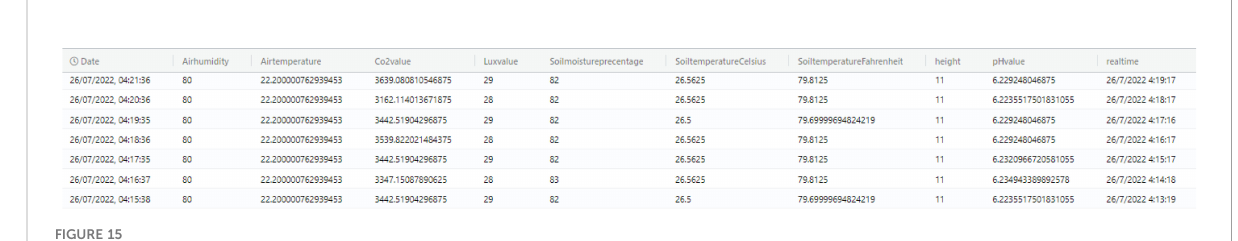
FIGURE 15 Archived sensing data in a data